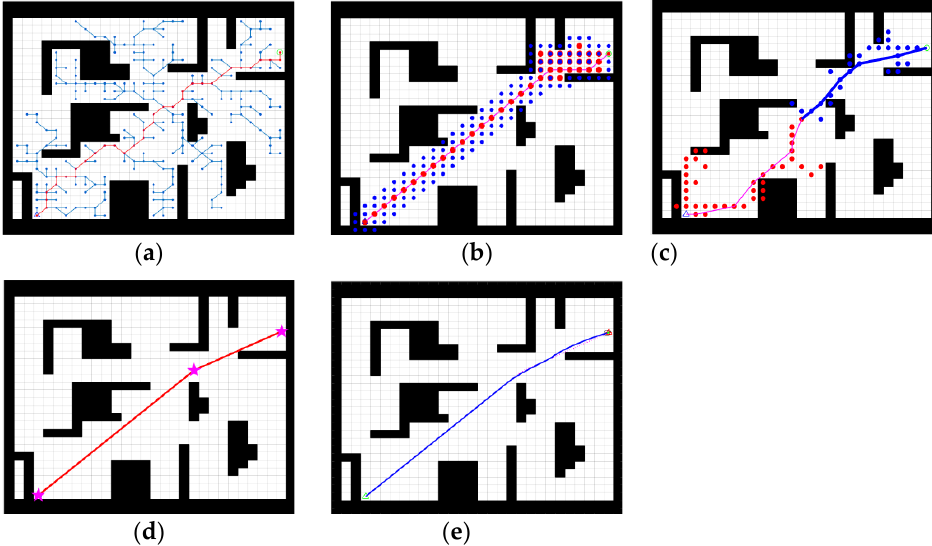
Figure 13. Five algorithms for planning the path. ( a ) Traditional RRT, ( b ) Traditional A*, ( c ) Traditional bidirectional RRT*, ( d ) Improved bidirectional RRT*, ( e ) Fusion algorithm.